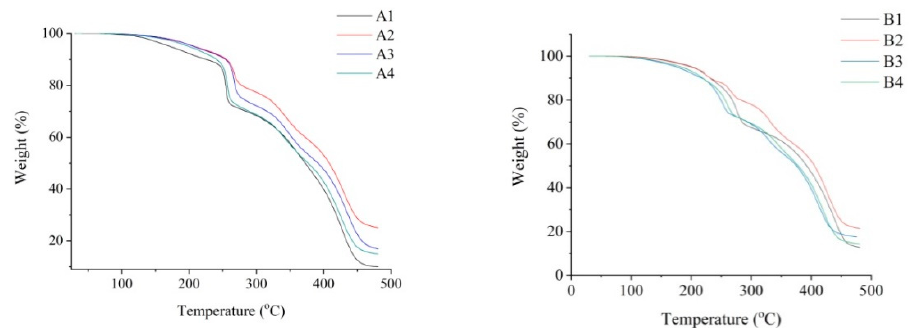
Figure 3. TG curves of polyurethane coatings.